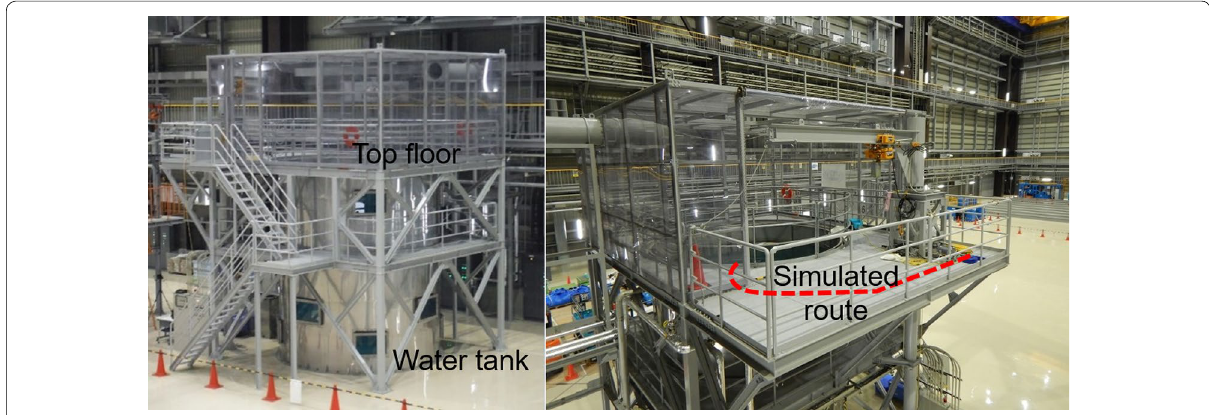
Fig. 11 Experimental site for simulated experiments